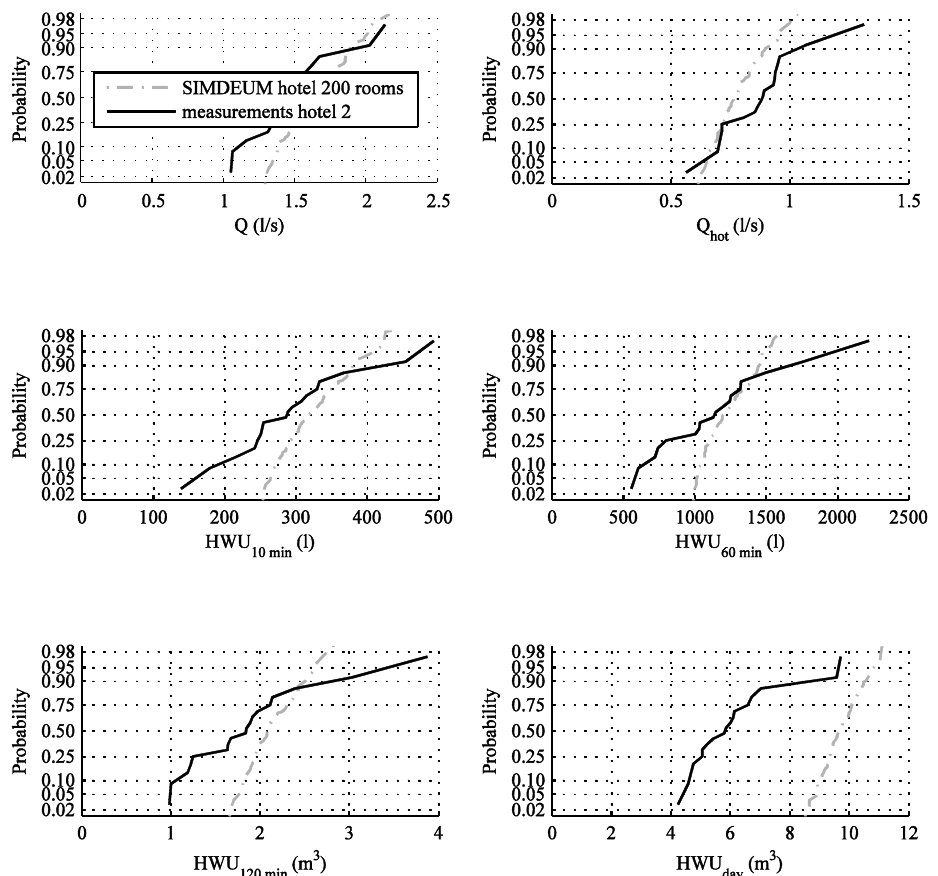
Figure 3. Frequency distribution of measured (18 weekdays at 1s scale) and simulated (100 days at 1s scale) peak demand values for hotel II: (a) MMF cold [Ls − 1 ], (b) MMF hot [Ls − 1 ], (c) HWU 10 [L], (d) HWU 60 [L], (e) HWU 120 [m 3 ], (f) HWU day [m 3